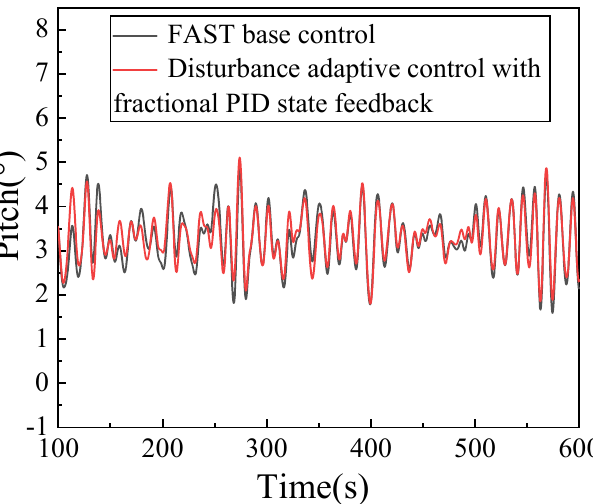
Figure 9. Comparison of surge displacement under two different control algorithms.